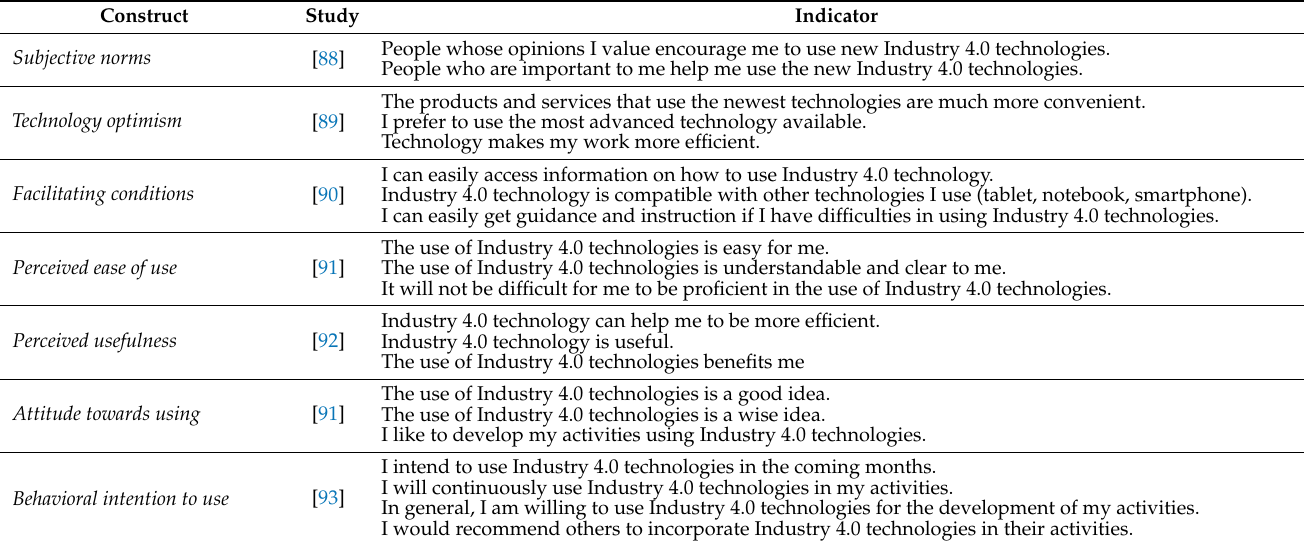
Table 1. Studies and indicators